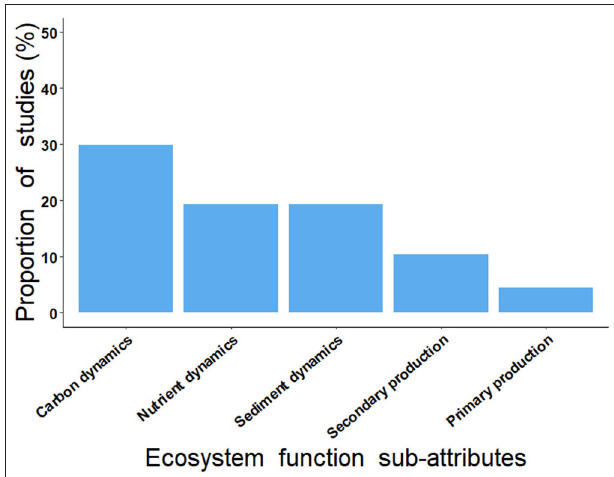
FIGURE 3 | Proportion of studies investigating ecosystem functions